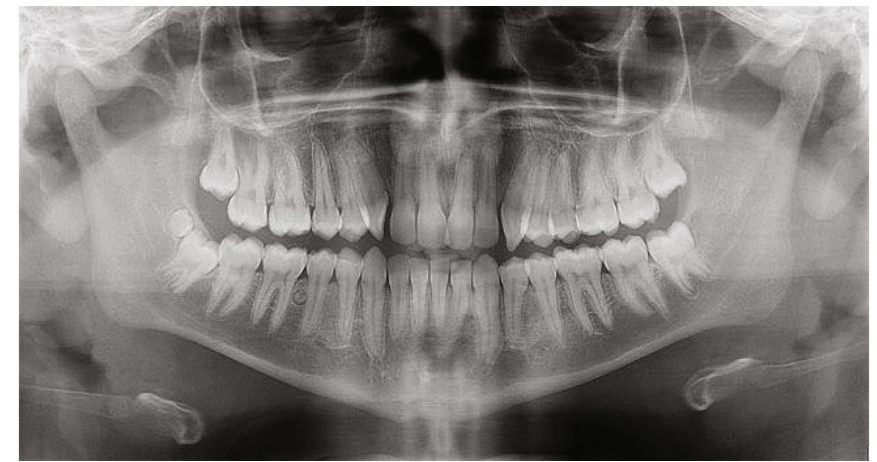
Figure 11: The panoramic radiograph taken after extracting 9 supernumerary teeth (all except the